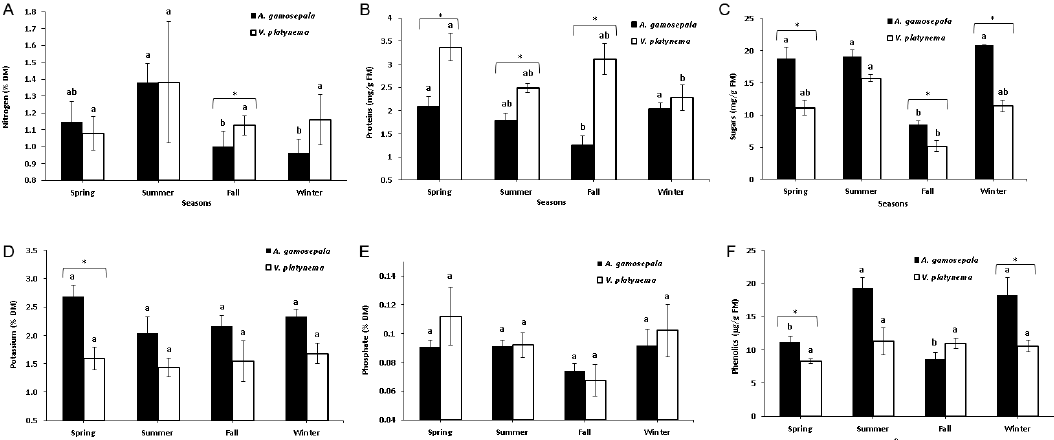
Figure 3. Nutritional parameters in leaves of Aechmea gamosepala and Vriesea platynema sampled in di ff erent seasons: ( A ) nitrogen; ( B ) proteins; ( C ) sugars; ( D ) potassium; ( E ) phosphate; ( F ) phenolic compounds. Di ff erent letters indicate significant di ff erences within species between seasons (ANOVA, Duncan’s test, p ≤ 0.05). Asterisks indicate significant di ff erences between bromeliad species within a given season (Student Test, p ≤ 0.05). Bars represent standard errors of the mean. Table 2. Levels of reducing sugars in leaves (mg / g FM) of Aechmea gamosepala and Vriesea platynema sampled in di ff erent sites (1 to 5) and seasons. Di ff erent letters in the column indicate significant di ff erences within species and season (ANOVA, Duncan’s test, p ≤ 0.05).